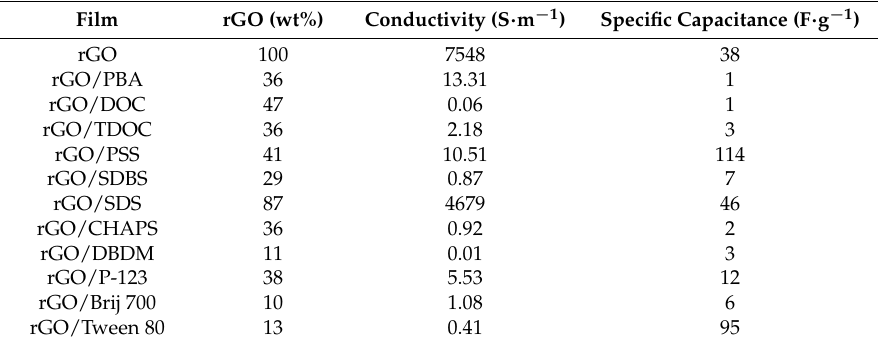
Table 3. This is a table presenting the Conductivity properties of various tested reduced graphene oxide-based inks. Reproduced with permission from M.J.Fern á ndez-Merino et al., Carbon; published by Elsevier, 2012 [54].